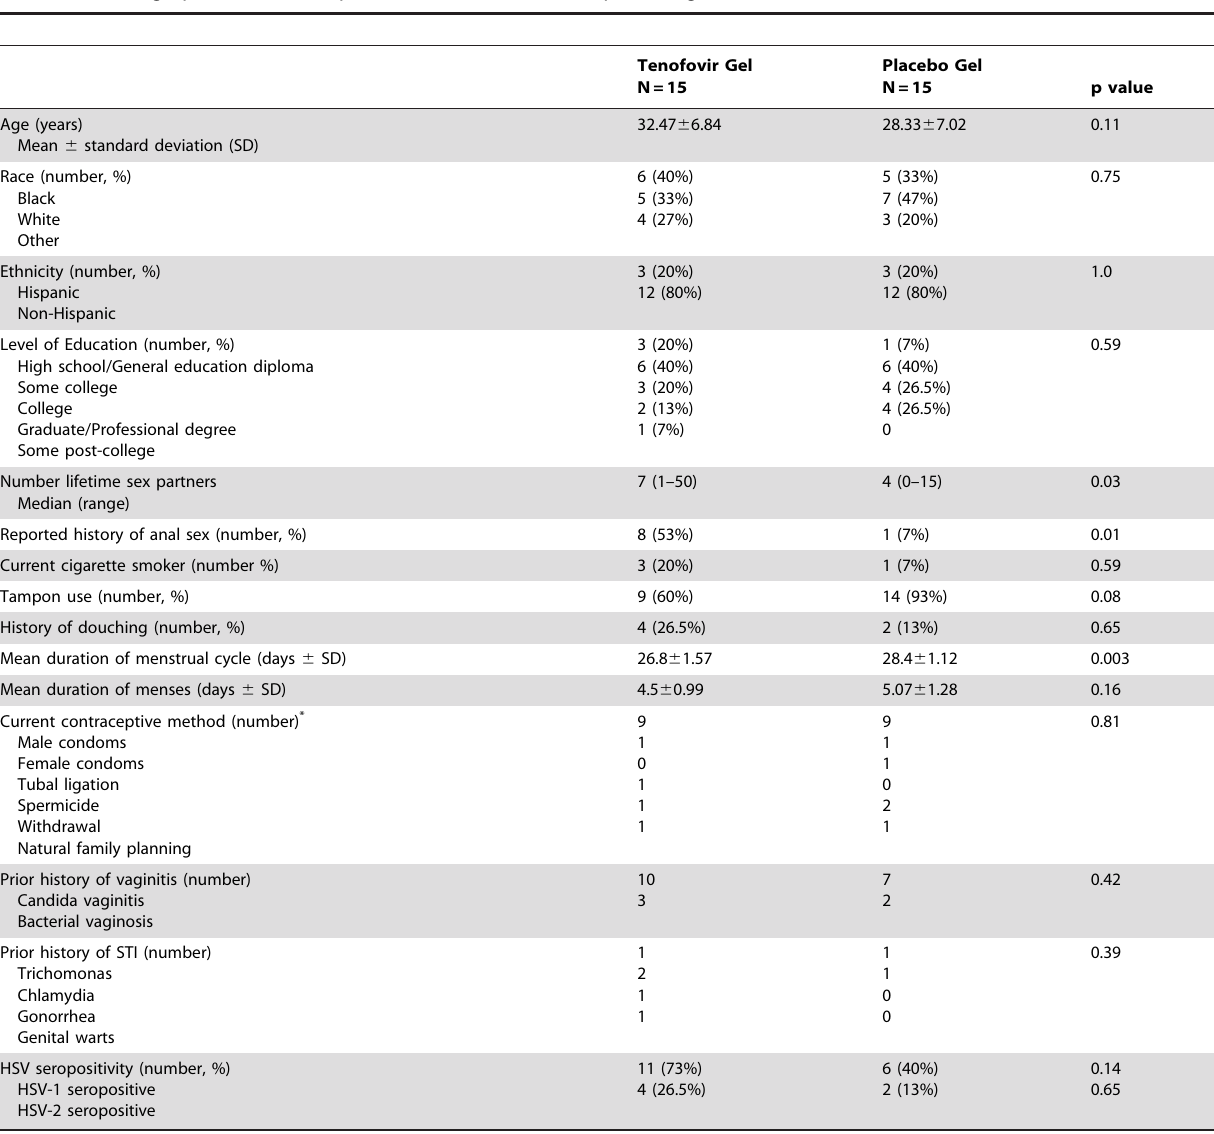
Table 1. Demographic data of recipients of 1% tenofovir and placebo